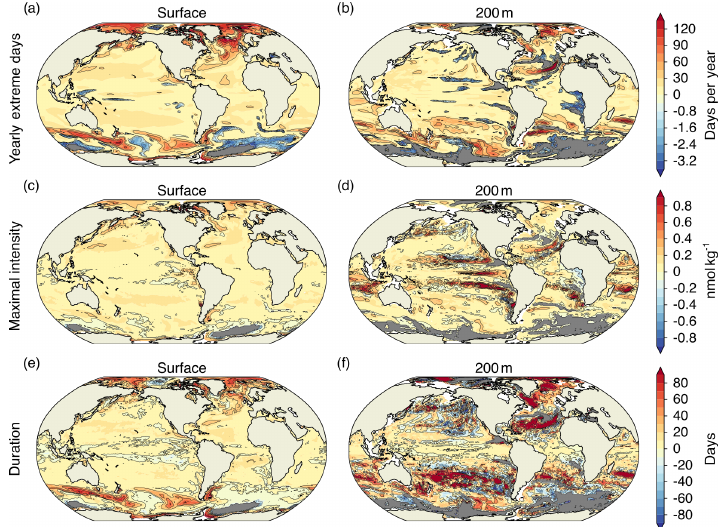
Figure A2. Simulated regional changes in [H + ] extreme-event characteristics between the preindustrial period and 2081–2100 following the RCP2.6 scenario. The extreme events are defined with respect to shifting baselines. Shown are the changes in yearly extreme days (a, b) , maximal intensity (c, d) , and duration (e, f) . Left panels show changes for the surface, whereas right panels show changes for 200m. Shown are changes averaged over all five ensemble members. The black contours highlight the pattern structures. Gray areas represent areas with no extremes during